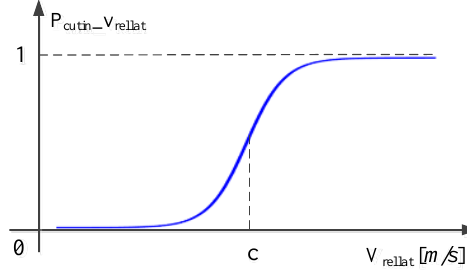
Figure 9. Cut-in possibility of lateral velocity.